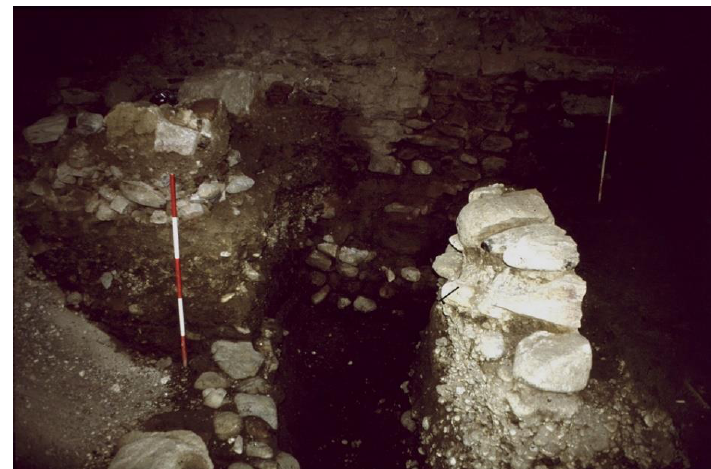
Figure 9. View of the eastern wall. The Torah Ark must have been of a different, free-standing type and was placed on an elevated landing—the foundation of which can be seen on the left side of the picture. Interior. Photo: The Maribor Regional Office of the IPCHS, Fond Maribor—Sinagoga.